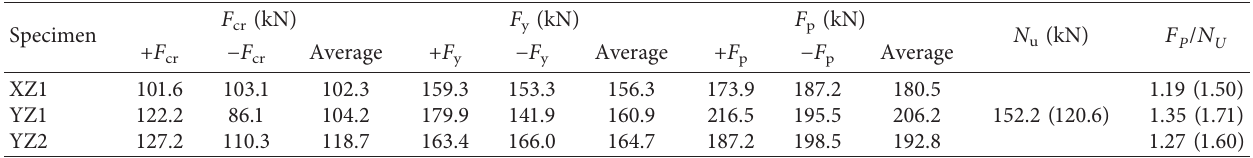
Table 6: Comparison of horizontal force in different states of specimens.